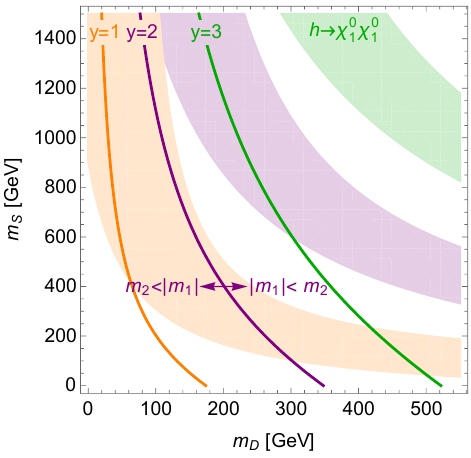
Figure 1 . Parameter space of possible lightest neutral states (cid:31) 0 Colored lines separate regions with y = 1 ; 2 ; 3. Colored areas are excluded by bounds on invisible Higgs decays h